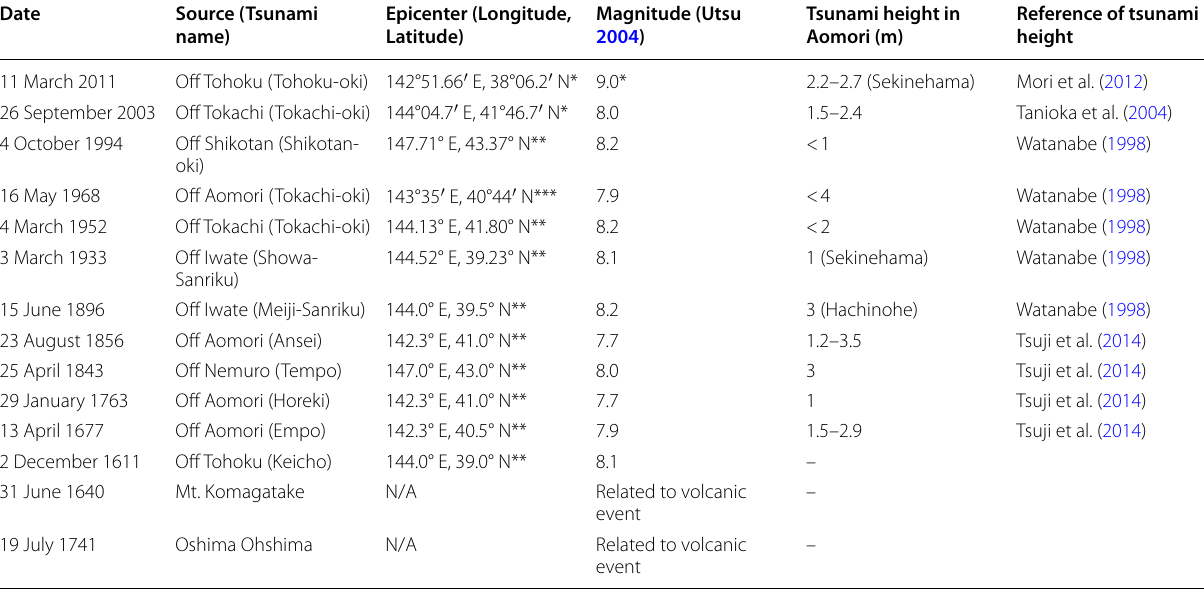
Table 1 Historical and modern tsunami list from 1611 to 2011 CE. The epicenters of each earthquake are displayed in Fig.